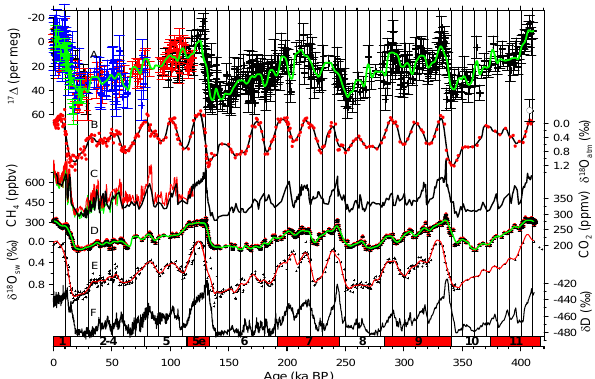
Fig. 1. (A) 17 1 from the Vostok, GISP2, GIPS2 and Siple Dome cores (Blunier et al., 2002) represented as black, red, blue, and green crosses, respectively. (B) δ 18 O in paleoatmospheric O 2 from Vostok (Petit et al., 1999). (C) CH 4 data from Vostok, GISP2 and Siple Dome, respectively in similar colors as the 17 1 data (see text for references and details). (D) Compiled CO 2 data from Vostok, Taylor Dome and EPICA Dome C (see text for details and references). (E) δ 18 O of seawater from Shackleton (2000). (F) δ D record from Vostok (Petit et al., 1999). The underlying time scale for the study is the orbitally tuned Vostok time scale from Suwa and Bender